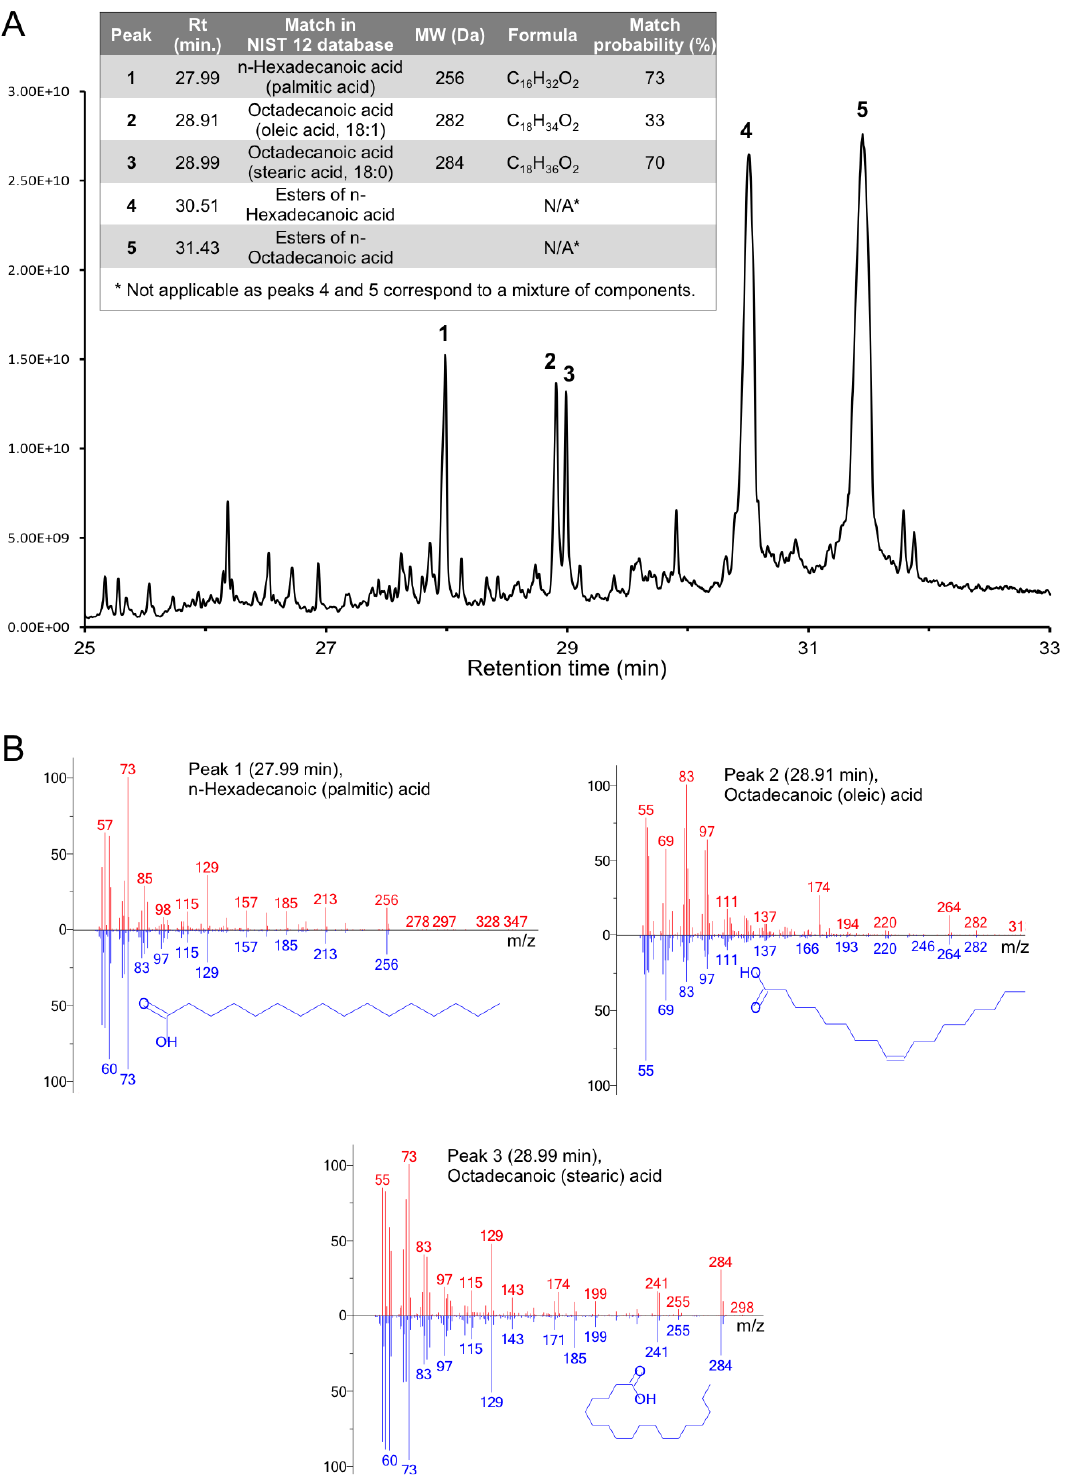
Figure 11. Identification of the inclusion compounds by GC-MS chromatography of gp5 β -BC organic extract. ( A ) GC-MS chromatography of gp5 β -BC organic extract; ( B ) Comparison of the Electron Impact (EI) spectra of the GC-MS compounds with NIST 12 database. The EI mass spectra of Peaks 1, 2 and 3 eluted respectively at 27.99, 28.91 and 28.99 min match those of the palmitic acid, oleic acid, and stearic acid, respectively.